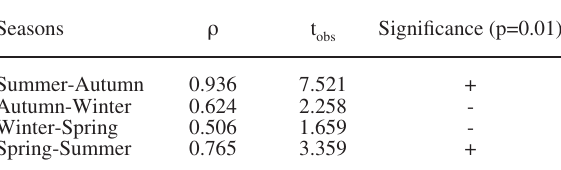
Table 6. – statistical comparison of the diet of P. acarne according to season. ρ , spearman coefficient of correlation; t , student test obs values; (+), homogeneous diet; (-), heterogeneous diet. seasons ρ t significance obs